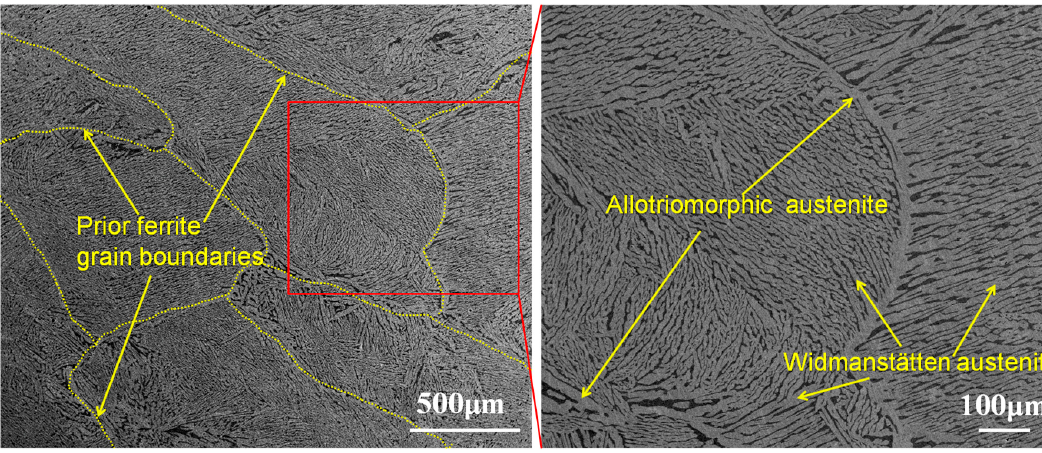
Figure 4. Typical microstructure of the F mode solidification.